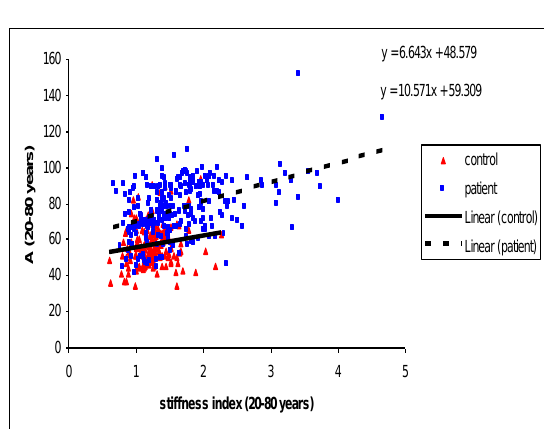
Fig. 2: The relation between stiffness index and peak late (A) diastolic filling velocities .